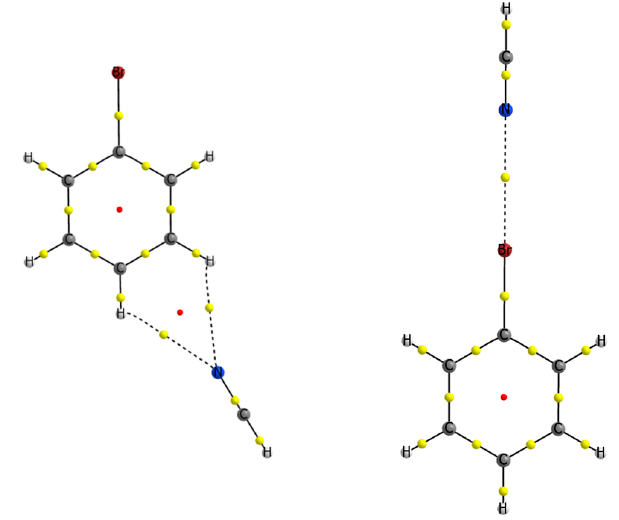
Figure 9. Molecular graph of some of the hydrogen- and halogen-bonded complexes between 1-bromobenzene and NCH. The locations of the bond and ring critical points are indicated with green and red dots, respectively.